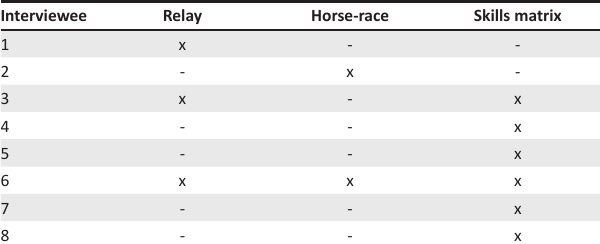
TABLE 1: Internal succession planning strategies of the considered boards